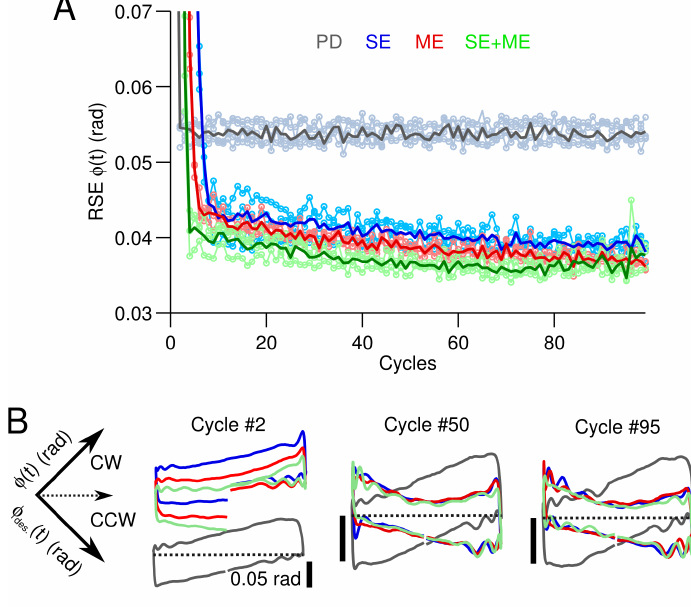
Figure 2. Performance during the control of the direct current motor with sinusoidal desired motion. ( A ) Control performance in terms of the root mean squared error (RSE) of φ ( t ) for the different types of climbing fiber (CF) averaged across the five experiments with different sets of initial synaptic weights. The mean value (thick line) and raw performance are shown. For reference, the performance with the proportional and derivative (PD) controller alone is shown (gray lines). ( B ) Yielded ( φ ( t ) , Y-axis) versus desired ( φ des . ( t ) , X-axis) shaft angle position (rotated − 45 degrees) when the different CFs are employed. The trajectories at Cycles #2, #50 and #95 are shown. Black scale lines are 0.05